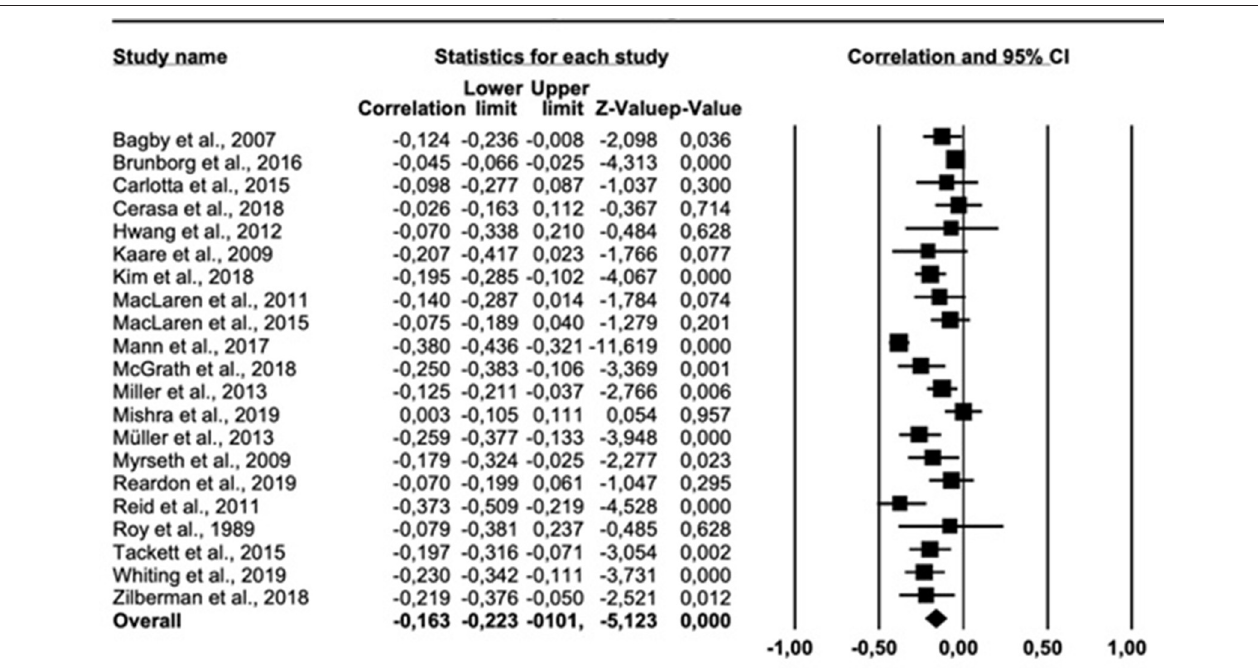
FIGURE 4 | Forest plot showing the relationship between gambling problems and agreeableness.